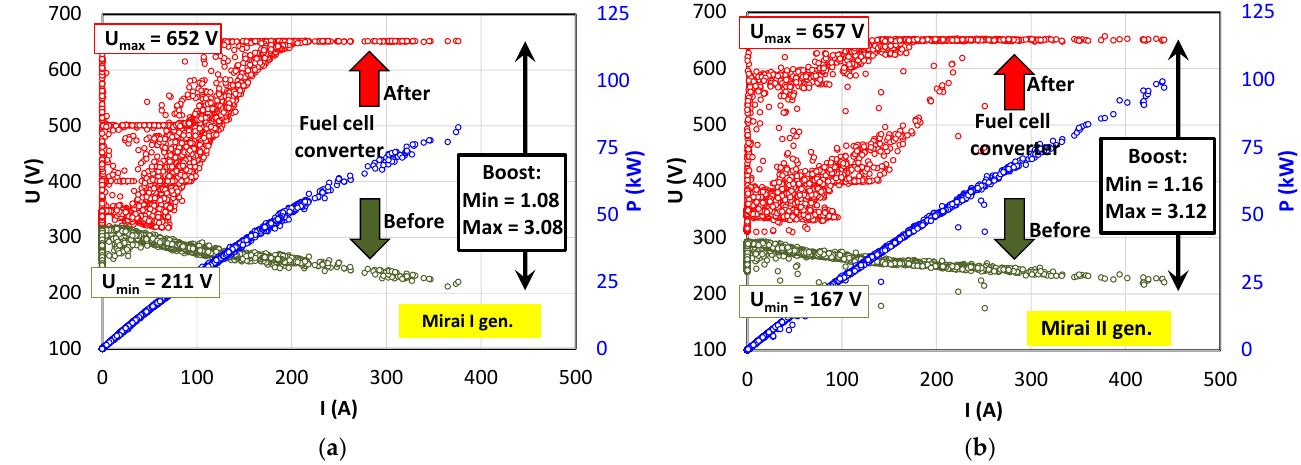
Figure 10. Current-voltage characteristics of a fuel cell stack: ( a ) first-generation drive; ( b ) second-generation drive.